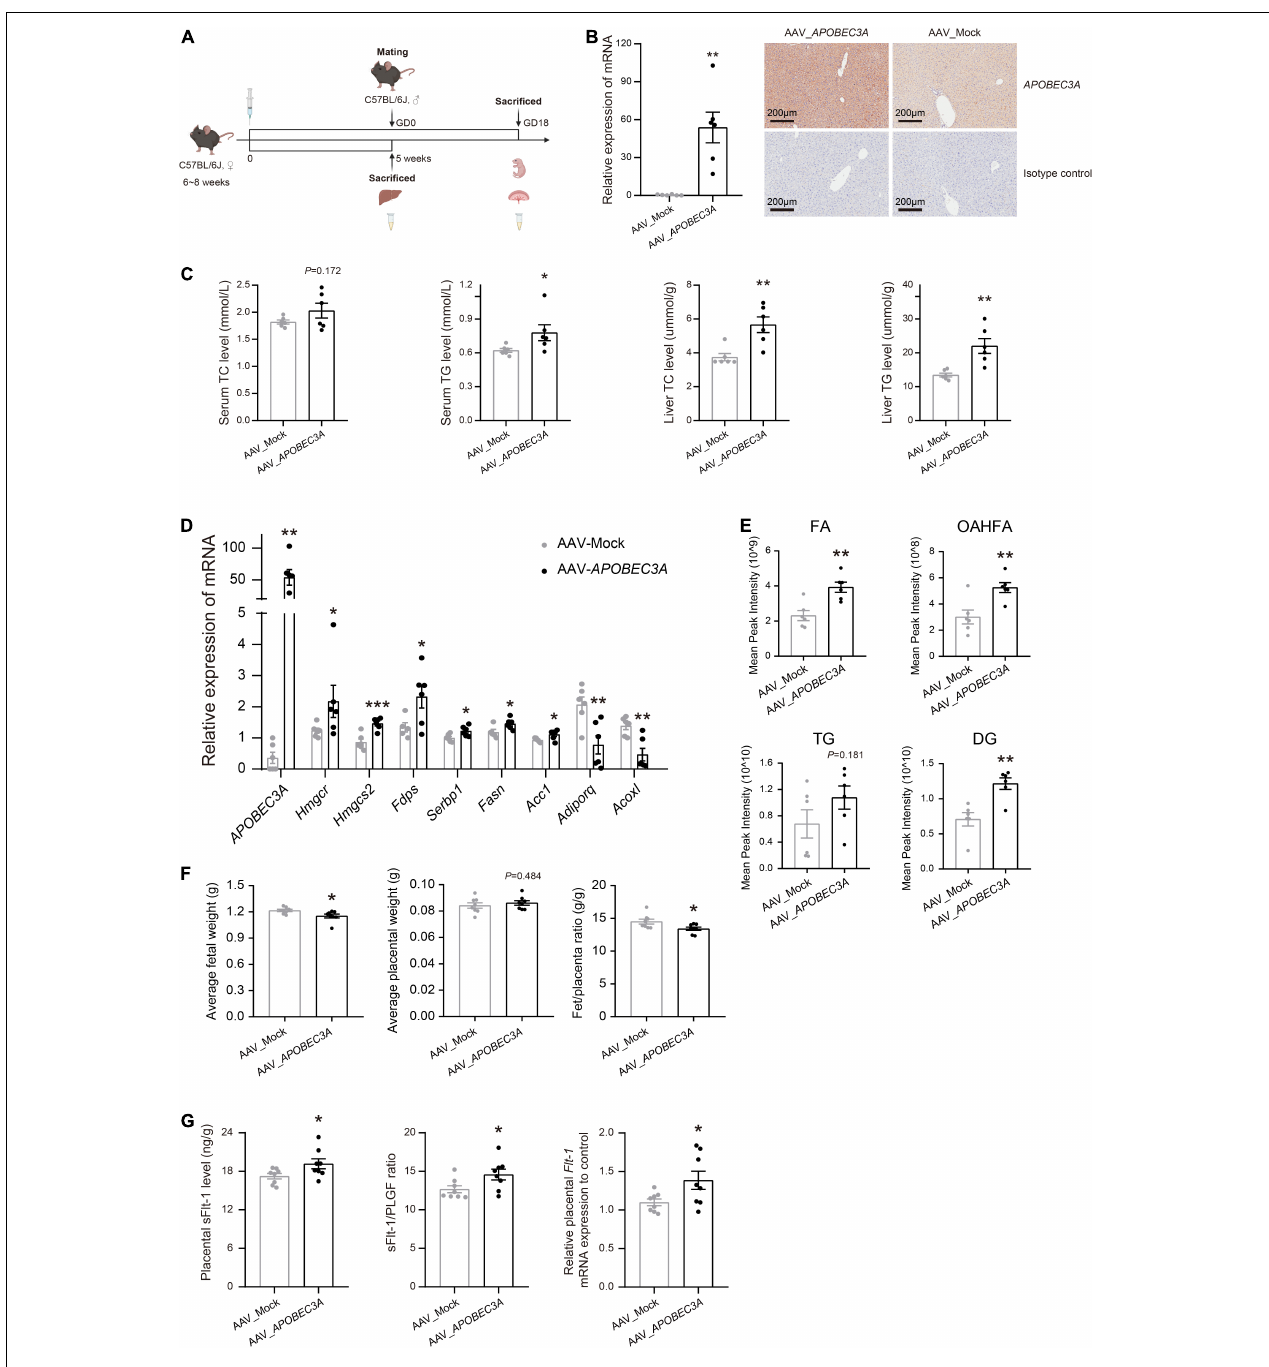
FIGURE 5 | Hepatic-specific overexpression of APOBEC3A in mice manifested abnormal lipid metabolism and PE-like symptoms. (A) Experimental design and timeline for the in vivo experiment in mice. (B) The mRNA and protein expression of APOBEC3A gene in the liver of non-pregnant mice injected with AAV_ APOBEC3A or AAV_Mock ( n = 6/group). (C) TC and TG levels in plasma and liver of mice injected with AAV_ APOBEC3A or AAV_Mock at 5 weeks after AAV administration ( n = 6/group). (D) The mRNA expression of multiple genes related to cholesterol and fatty acid metabolism in mice injected with AAV_ APOBEC3A or AAV_Mock ( n = 3–6/group). (E) Levels of FA, OAHFA, TG, and DG metabolites in mice injected with AAV_ APOBEC3A or AAV_Mock ( n = 6/group). (F) The average weight of fetuses and placentas in pregnant mice injected with AAV_ APOBEC3A or AAV_Mock ( n = 8/group). (G) The protein and mRNA levels of sFlt-1 in the placenta of pregnant mice injected with AAV_ APOBEC3A or AAV_Mock ( n = 8/group). The unpaired two-tailed Student’s t -test determined statistical significances between two groups. Data were represented as the mean ± SEM. *** P < 0.001, ** P < 0.01, * P < 0.05. FA, fatty acids; OAHFA, (O-acyl)-1-hydroxy fatty acids; TG, triglycerides; DG, diacylglycerol. GD, day of gestation.